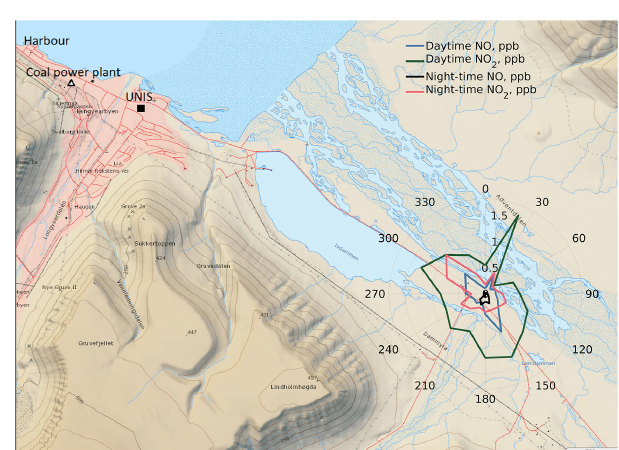
Figure 6. Distribution of average NO and NO 2 concentrations over wind directions in daytime and night-time at the station in Adventdalen. The background map is made using the online tool https://toposvalbard.npolar.no/, provided by the Norwegian Polar